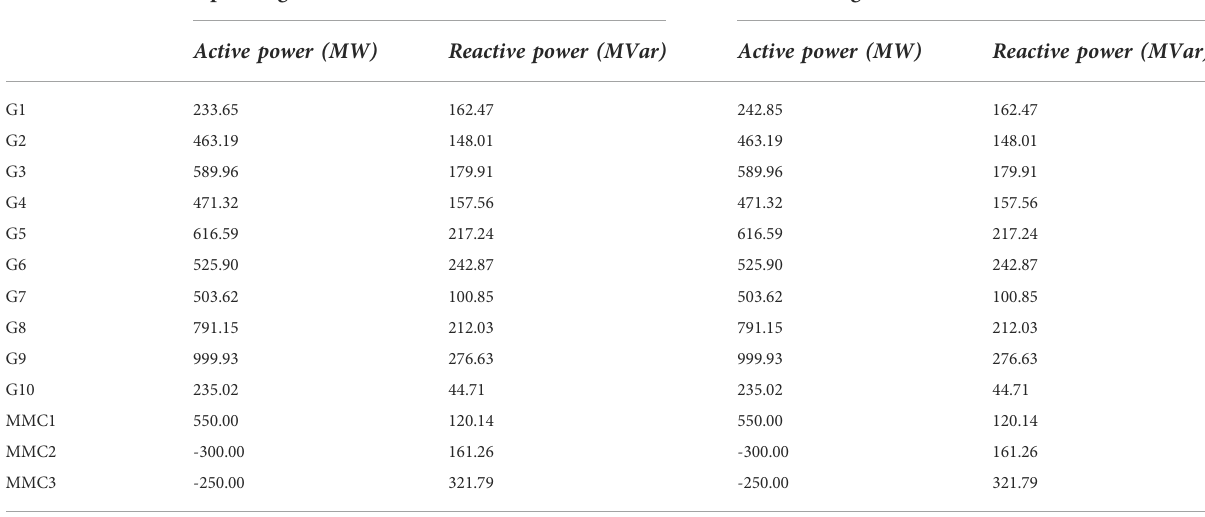
TABLE 3 Value of